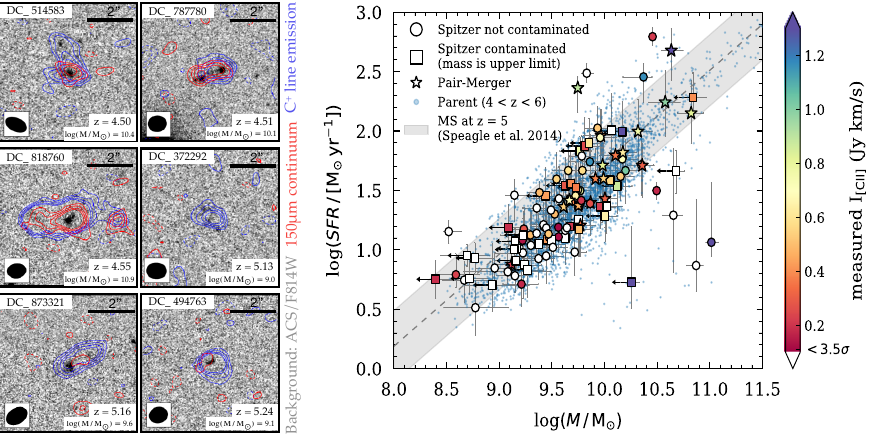
Figure 2. ALPINE observed 118 galaxies on the star-forming main-sequence at redshifts z = 4.4–5.9. The ALMA observations provide measurements of the 158 µ m C + line emission as well as the surrounding (rest-frame ∼ 150 µ m) dust continuum. Left Panels: Hubble ACS/F814W cutouts of six ALPINE galaxies at different redshifts with a range of C + and far-IR emission morphologies. Contours show C + emission (blue) and dust continuum (red), target IDs, stellar masses, and redshifts are also indicated. Right Panel: Distribution of the ALPINE galaxies (large symbols) and their parent sample (blue dots) on the main-sequence (gray) at z ∼ 5. The color of the symbols indicate the observed C + line emission. Different symbols identify mergers (stars) as well as galaxies whose Spitzer photometry is contaminated by neighboring objects (squares); in which case, their stellar masses are likely overestimated. Adapted from Ref.